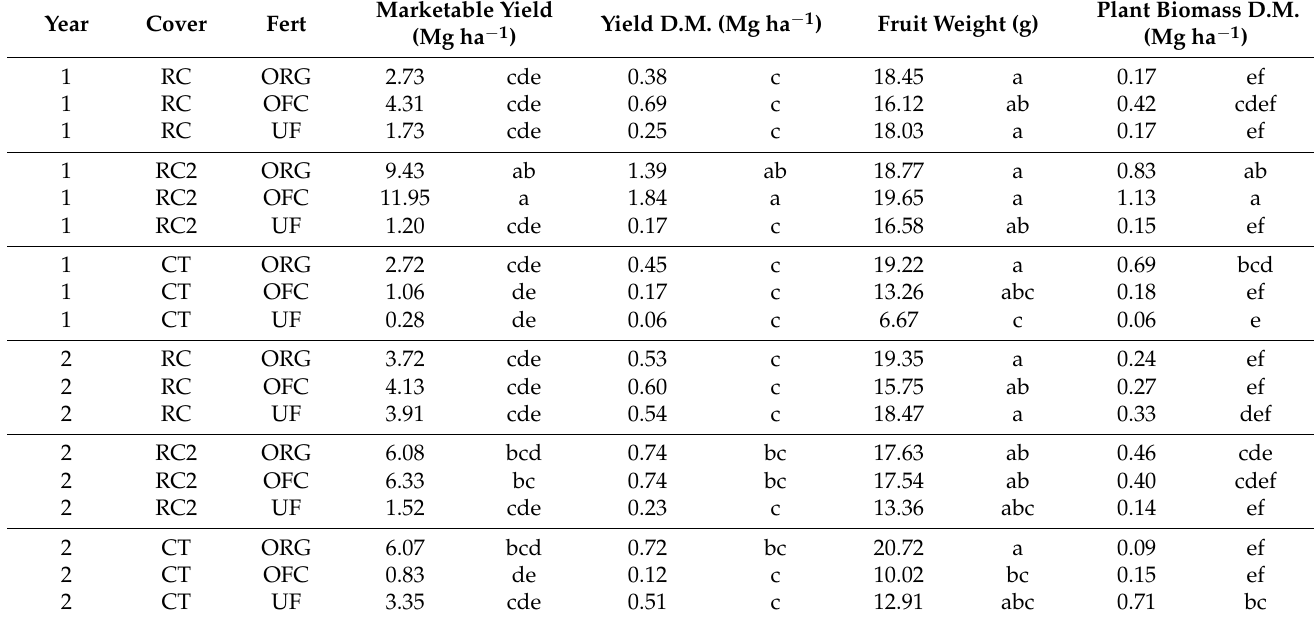
Table 5. Marketable yield fresh weight and yield dry matter, fruit weight and plant biomass dry matter in the two-year pepper